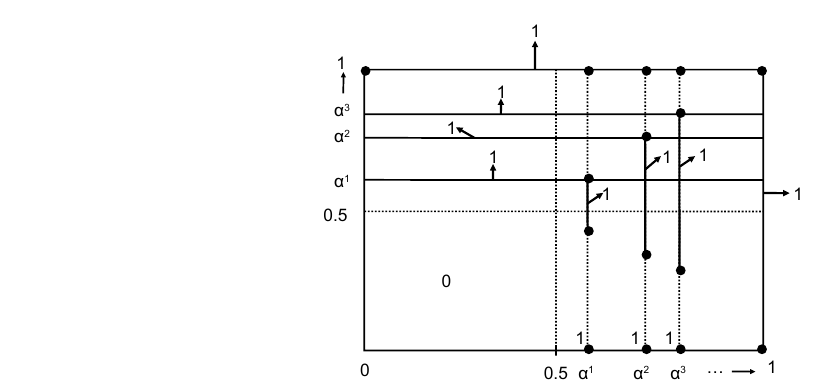
Figure 2. Example 3: The payoff function for player 1.